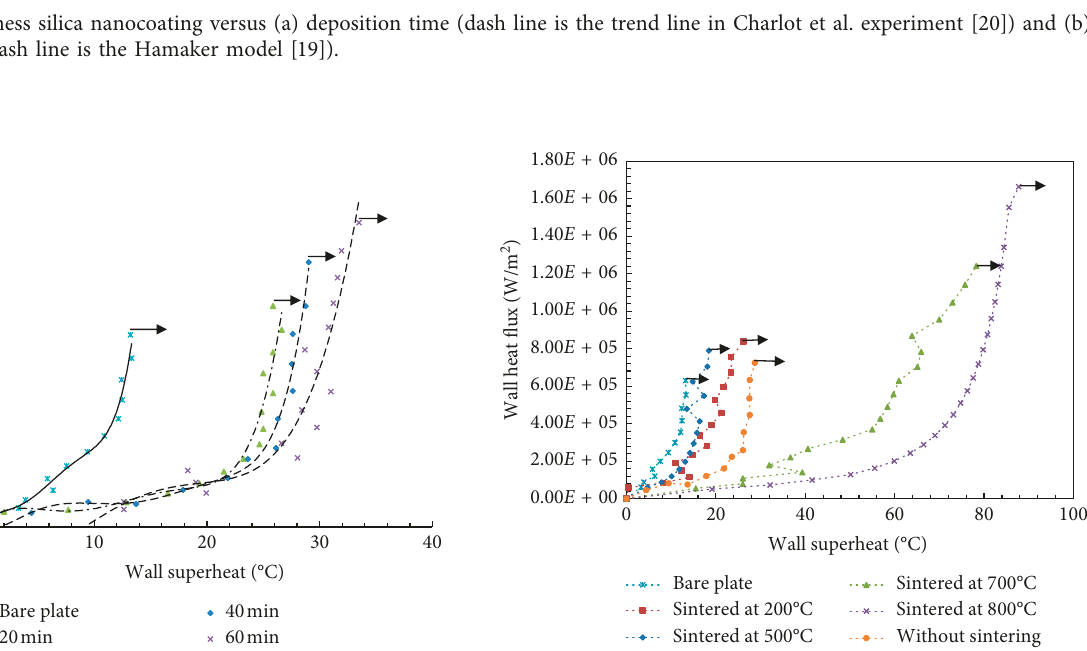
Figure 9: Pool boiling curves for bare and coated plates. Figure 10: Pool boiling curves for bare and sintered